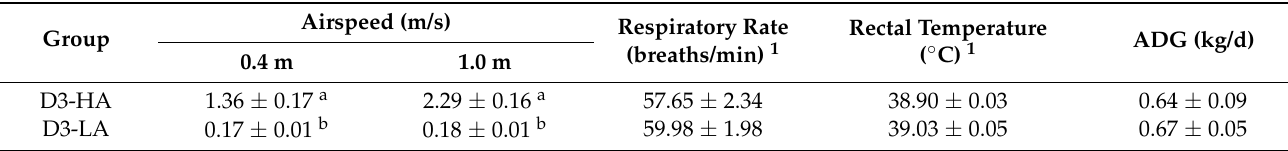
Table 4. Airspeeds, respiratory rates, rectal temperatures, and average daily gain (ADG) (mean ± SEM) of calves of groups D3-HA and D3-LA. Group